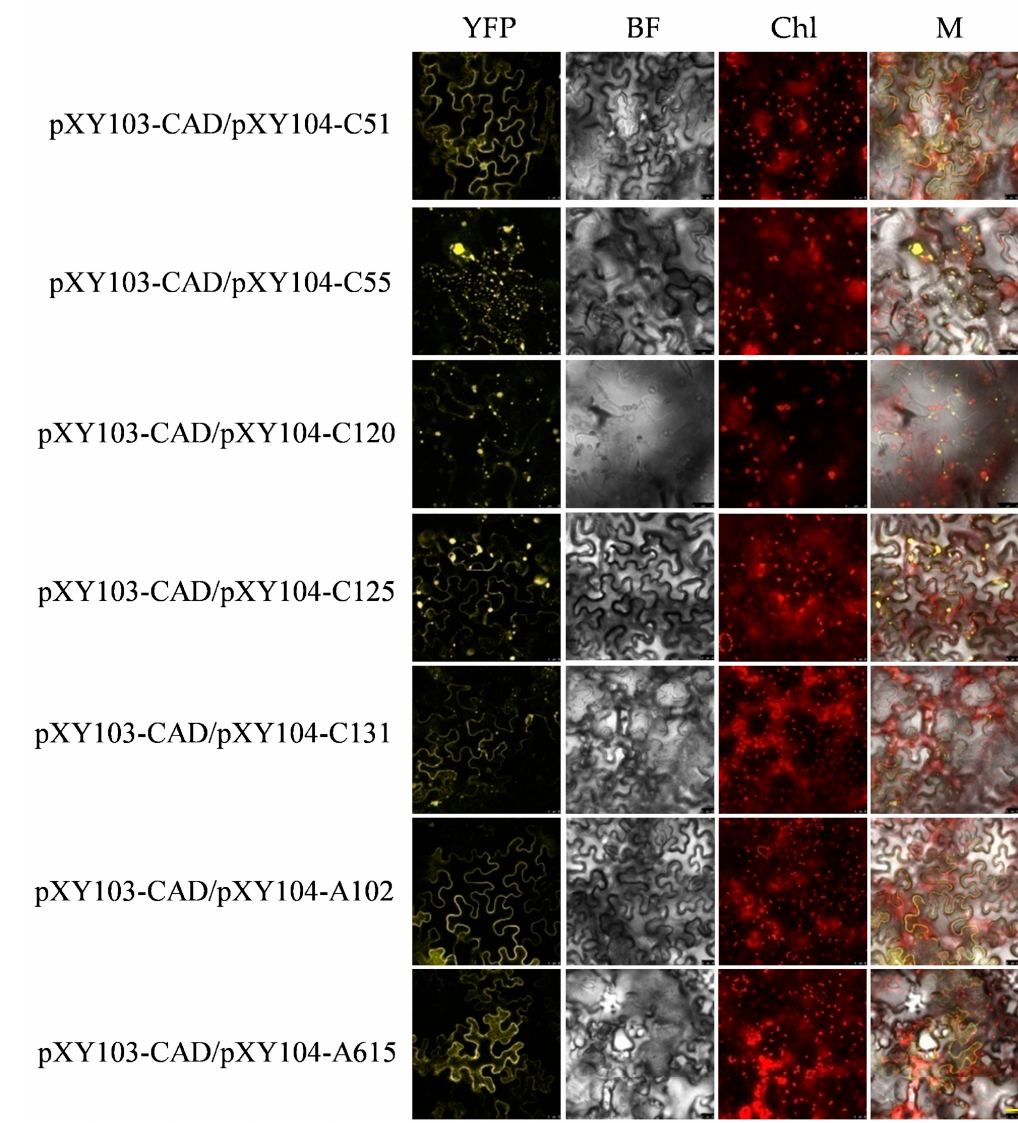
Figure 7. Fluorescence signal of CAD and its interacting proteins in tobacco mesophyll epidermal cells. YFP: yellow fluorescent protein; BF: bright field; Chl: autofluorescence of chloroplasts; M: merging of YFP, BF and Chl images. The value of scale bar with yellow color on the lower right of the figure is 25 μ m.